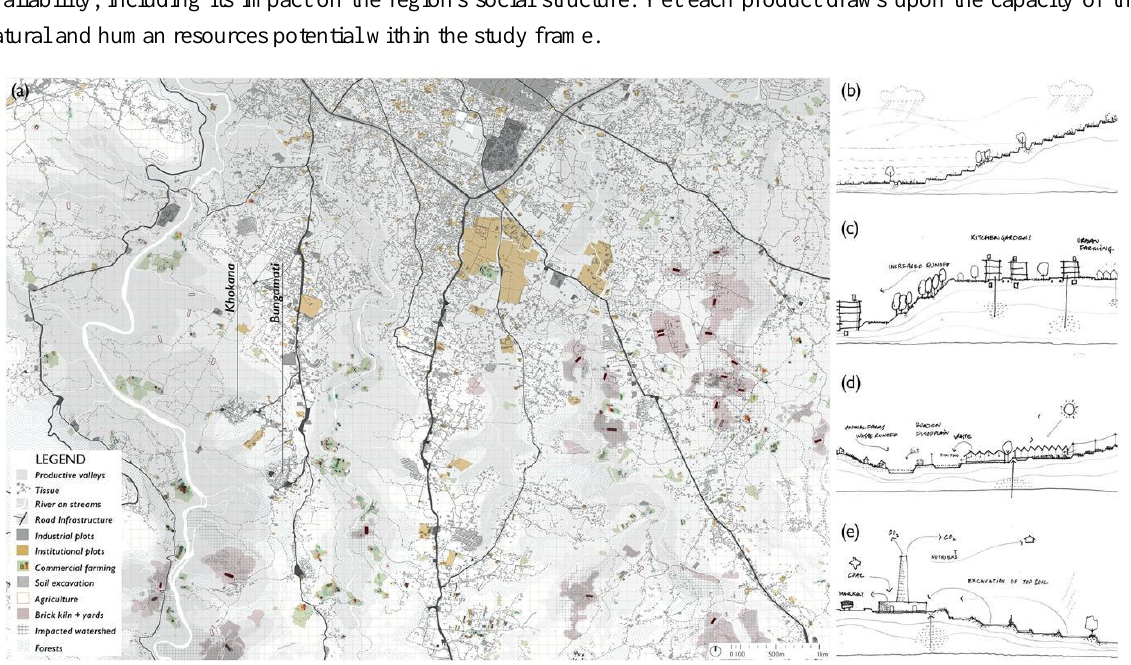
Figure 3. Defining the productive frame & Impact of resource extractions Landscape Impacts; (a) Map; Urban expansions happen quite randomly leading to interesting intertwined urban-landscape morphologies; (b) rainfed farming slopes outside Khokhana; (c) traditional settlements ;(d) farming cooperatives in the along the river valley; (e) Brick Factories within agriculture fields. Source: